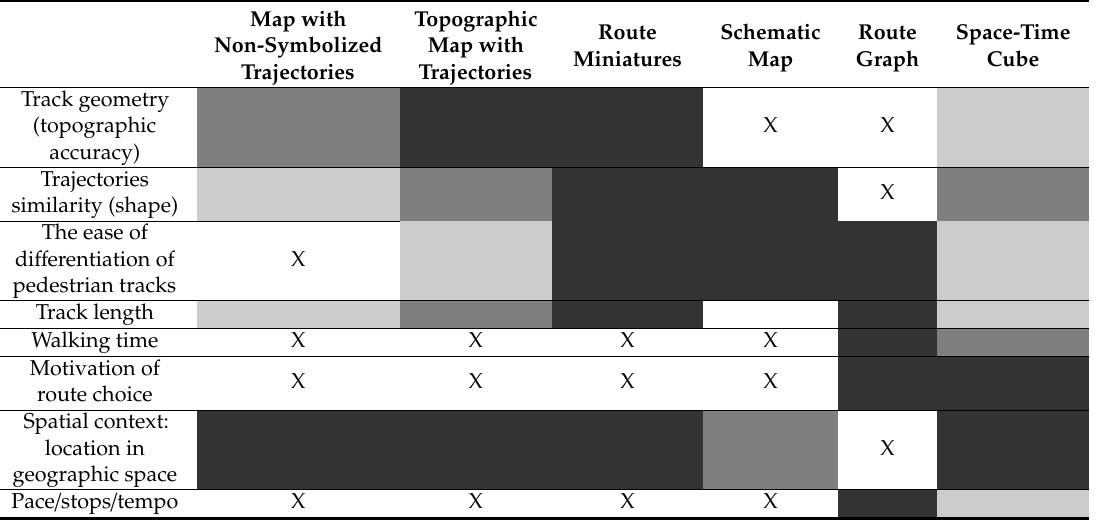
Table 2. Usefulness of the proposed visualization methods for analyzing and interpreting selected features of spatial behavior and pedestrian trajectories (dark grey: very good; grey: good; light grey: possible, white with strikethrough: inapplicable). Map with Topographic Route Schematic Route Space-Time Non-Symbolized Map with Miniatures Map Graph Trajectories Trajectories